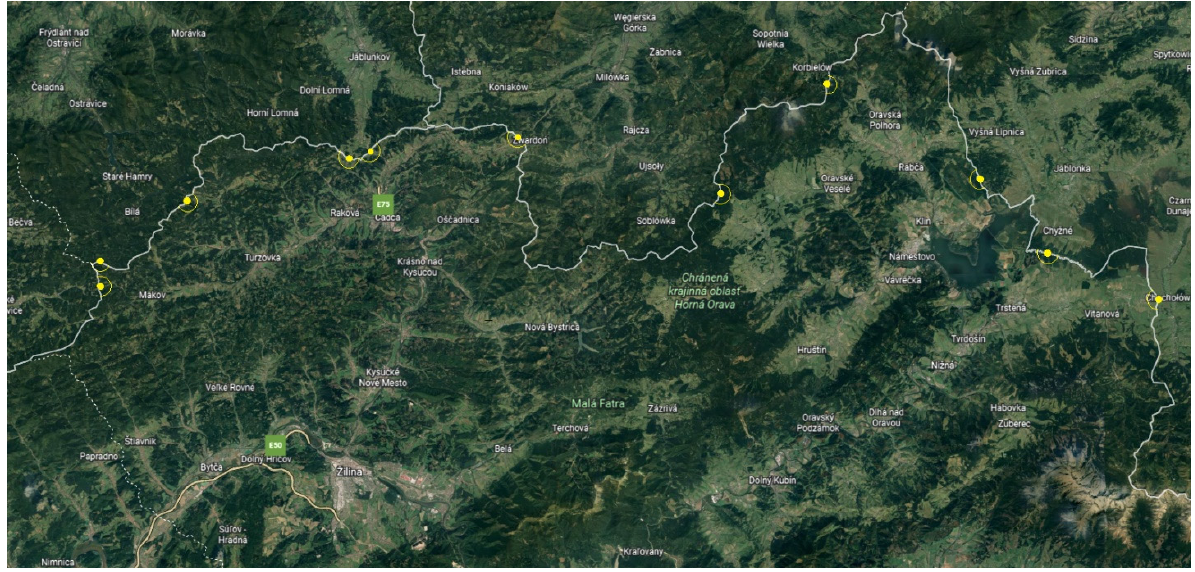
Figure 14. Map of the hazardous area of leakage dangerous substances in the border areas of the Žilina region-representation of the extent of the endangered area by the leakage of a dangerous substance in the direction of wind flow from 0° to 360° [24,25].